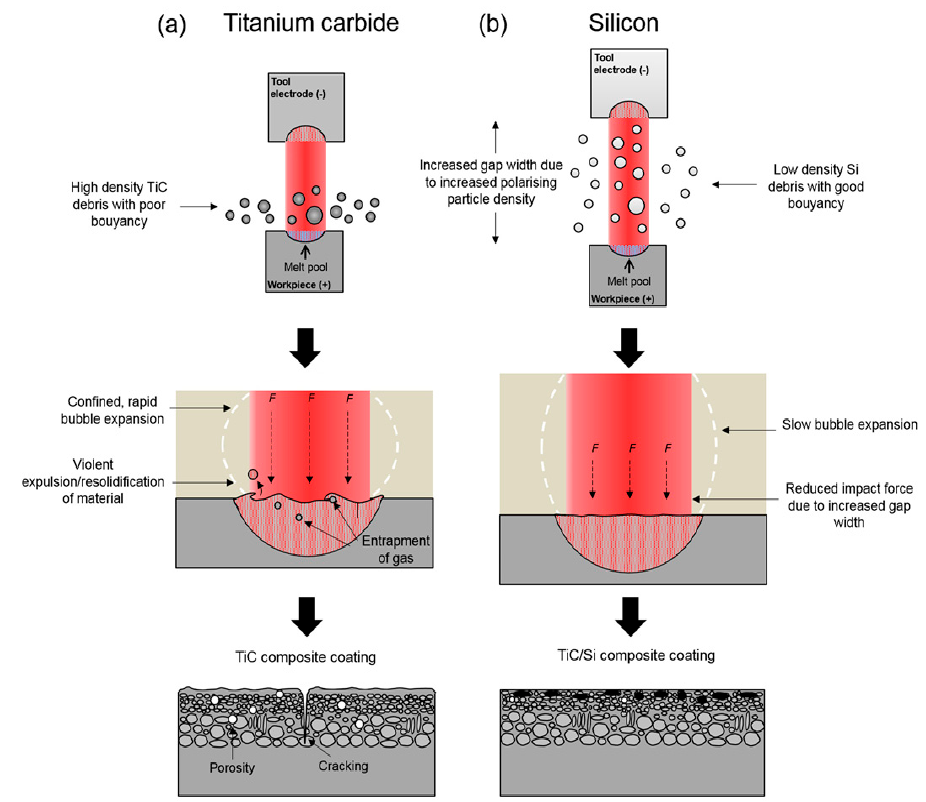
Figure 16. Schematic of mechanism involved in defect-free coating [149]. Table 7. Summary of the past literature work on EDC with a multi-layer electrode.